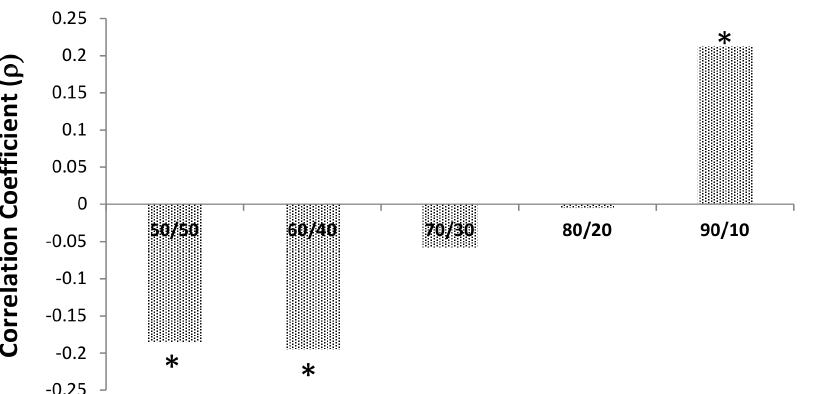
Figure 3. Correlations (Spearman’s r ) Between Post Delay Decision Times and Average Acceptance Rates Following the 1 Second Time Delays for the Different Offers. * p , .01